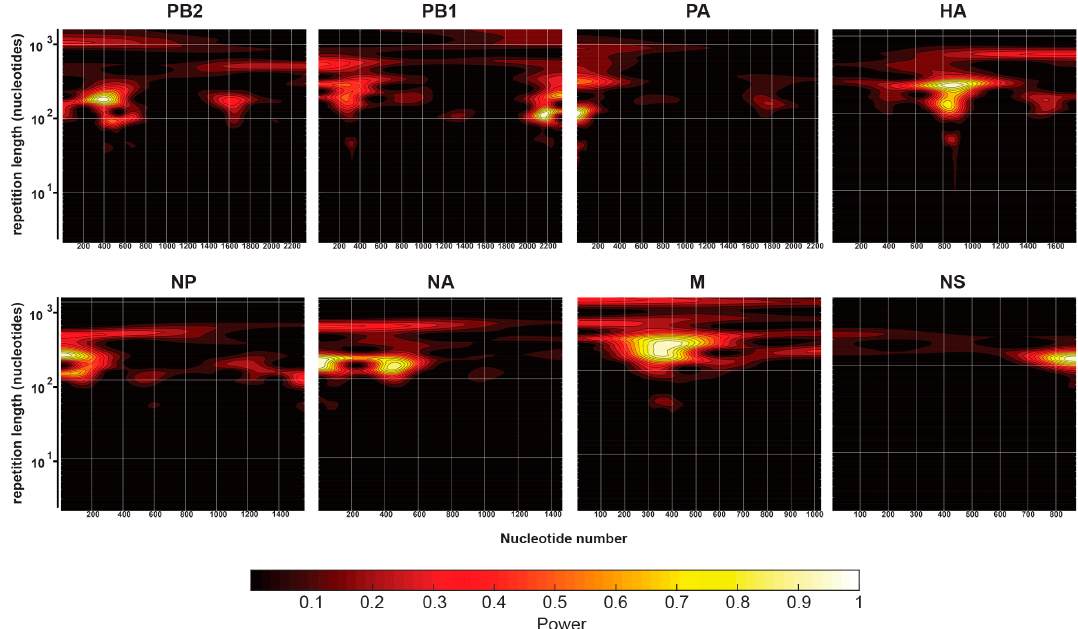
Figure 4. Normalized wavelet transforms of NP-vRNA binding profiles for each seasonal H3N2 A/Panama/07/1999 segment. Binding profiles were analyzed for patterns that could originate from NP-vRNA interaction and occur at regular intervals with the NP scaffold structure. Regular NP contact over the entire length of the NP vRNA segment should show up as a strong horizontal smear (yellow-white) across the graph, which is centered vertically at the repetition interval. The signal of the wavelets power is color coded, according to the scale bar. Each graph is presented as the x-axis: location along the segment, y-axis: interval over which binding is repeated. Repetition lengths are meaningful for a repetition length under 100 nucleotides because a signal at long repetition lengths of the order of the segment length could involve chance contact at 2 to 3 locations only.